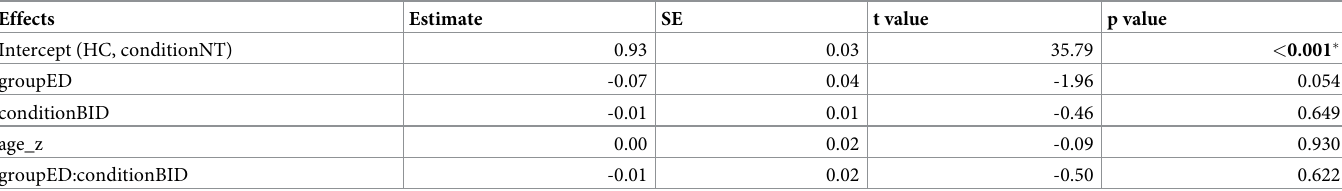
Table 5. Random effects for probability of staying after a common transition and a rewarded trial based on collected data (frequency